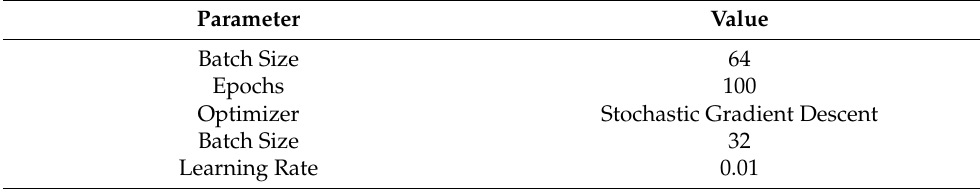
Table 6. Semi-supervised training parameters.